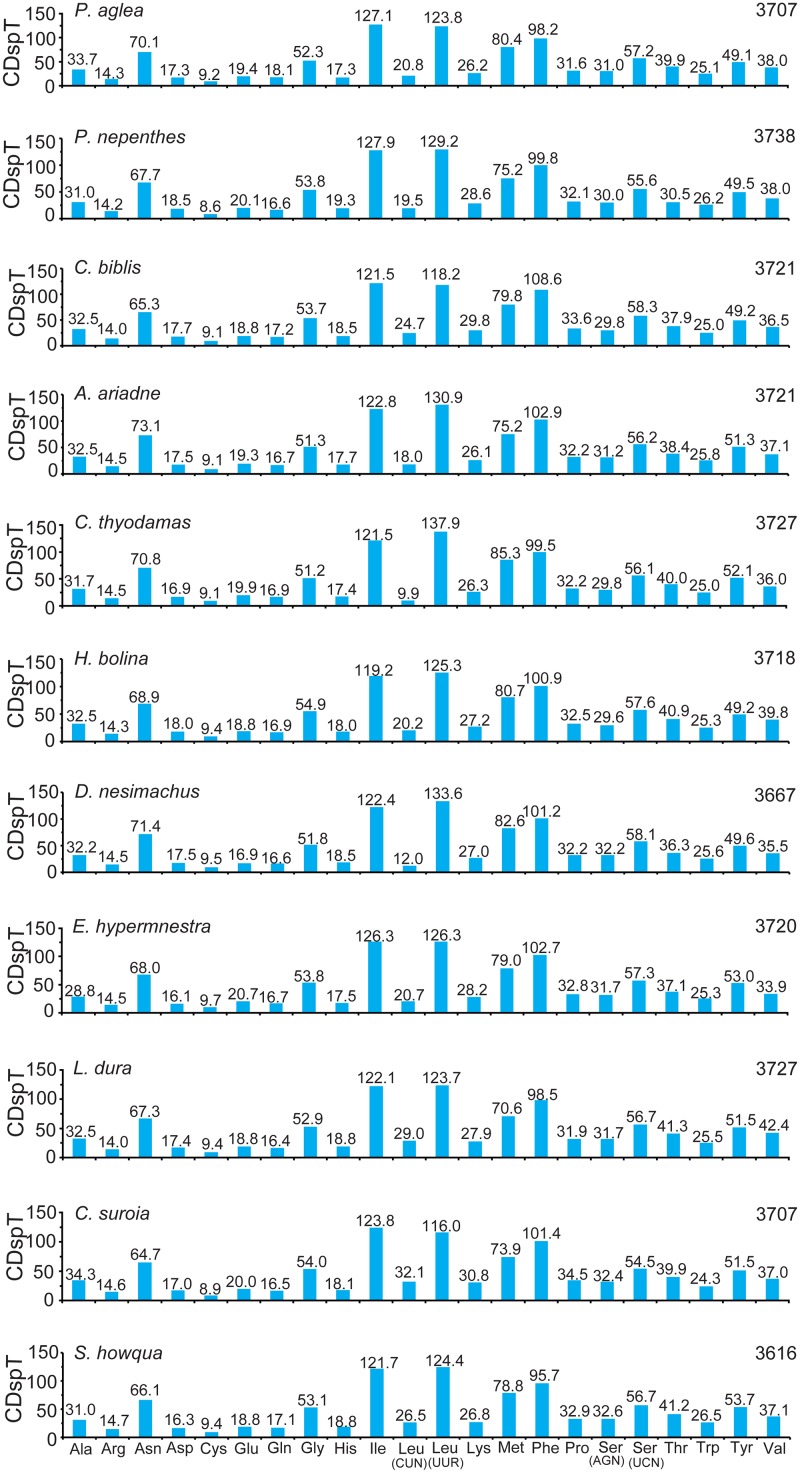
Codon distribution in the eleven newly sequenced nymphalid mitogenomes.Numbers to the left refer to the total number of codons. CDspT, codons per thousand codons. Codon families are provided on the x axis.